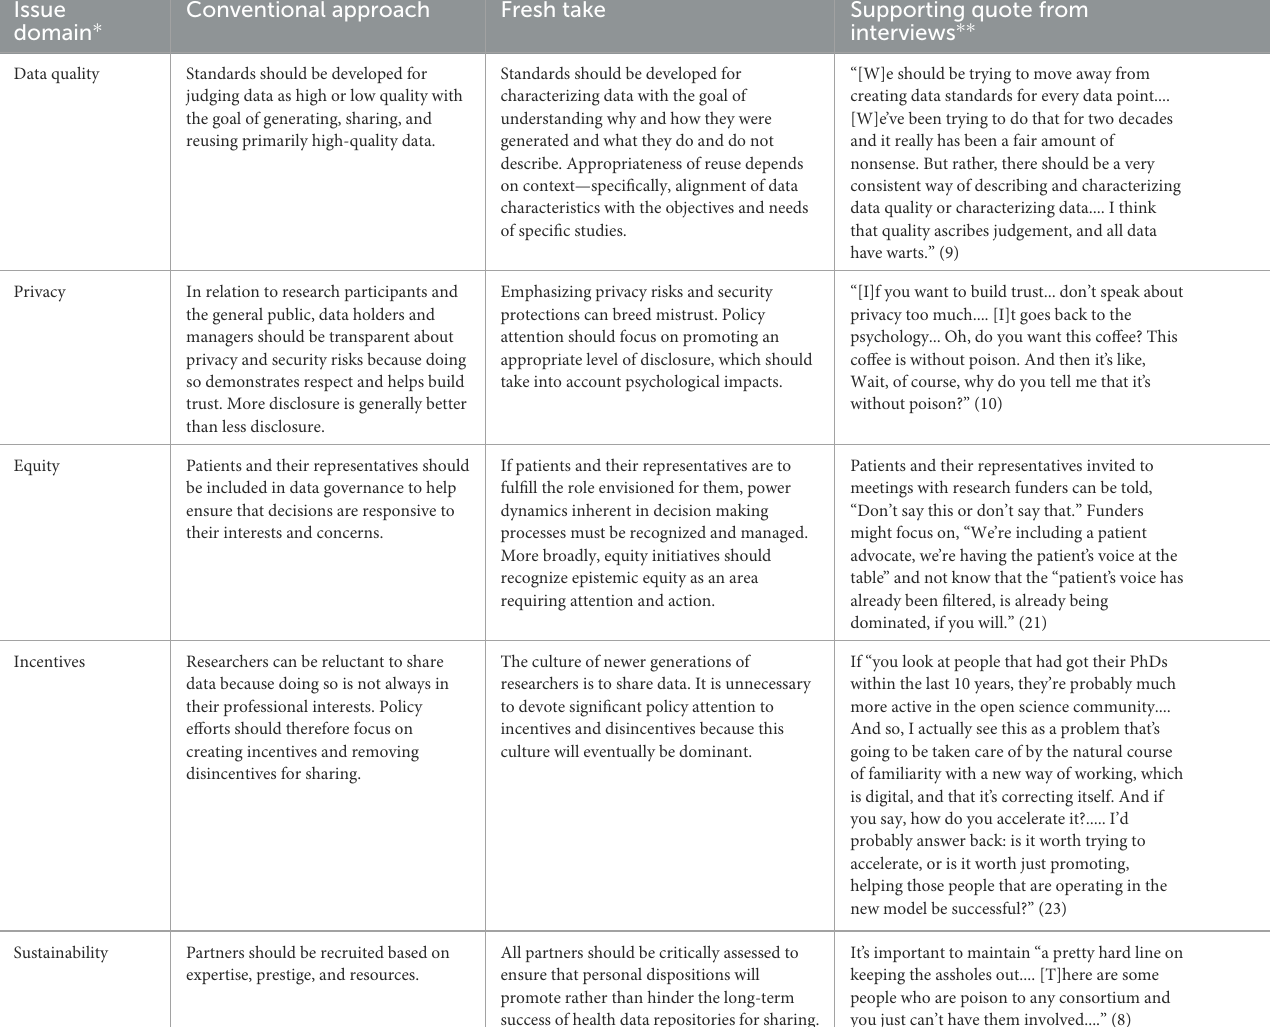
TABLE 2 Insights on health data sharing issues shared by interviewees ( N =